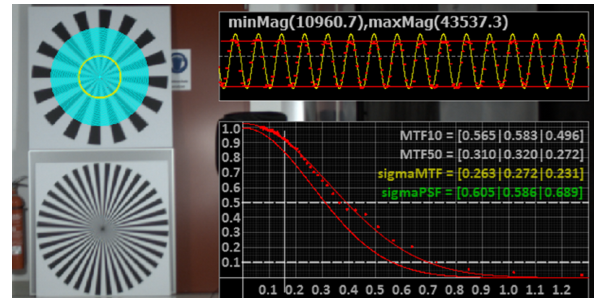
Figure 7. Resolving power determination. Designated test pattern Siemens-star (left), radial modulation analysis (top-right), and resulting MTF and PSF